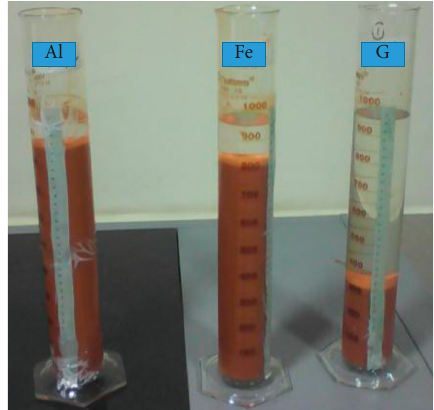
Figure 7: Concentrated laterite suspension undergoing sedi- mentation after adding alum (Al), FeCl 3 (Fe), and Grewia spp. biopolymer